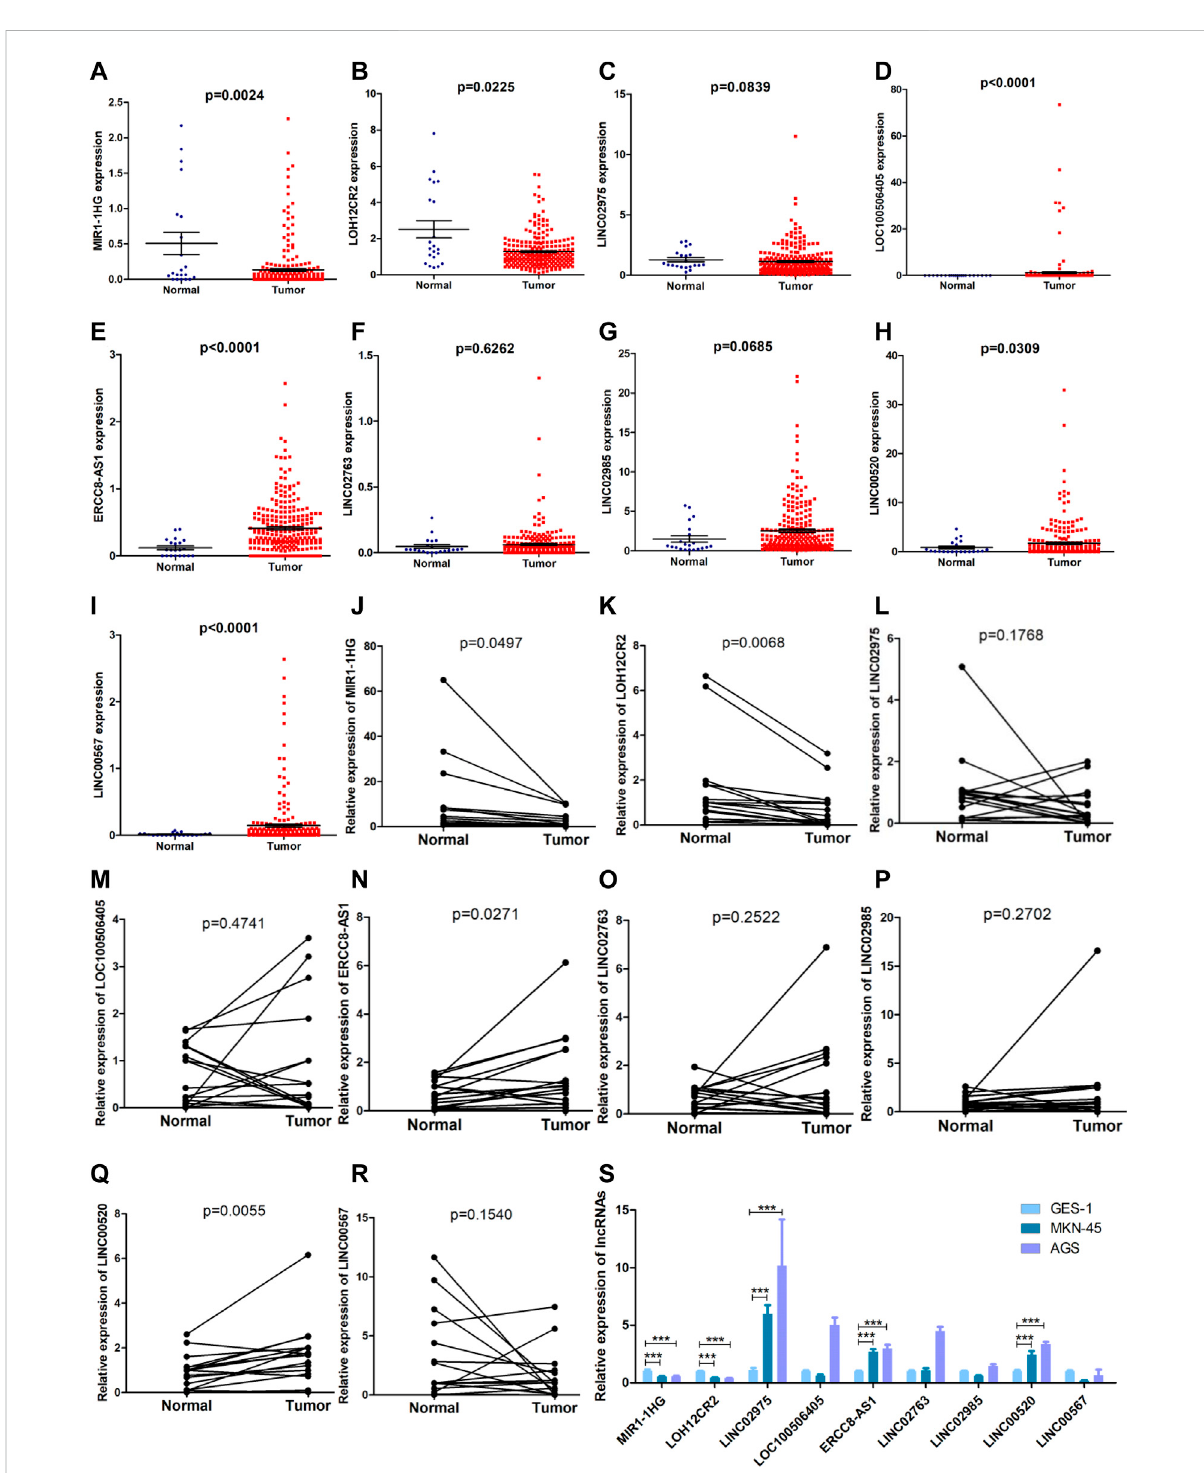
FIGURE 10 Evaluation of the expression of nine lncRNAs in the risk model. (A – I) Comparison of the expression levels of the nine lncRNAs between tumor tissues and normal tissues in TCGA datasets (Mann-Whitney U test). (J – R) The expression levels of the nine lncRNAs in 16 paired GC samples detected using qRT-PCR (paired t test). (S) The expression levels of the nine lncRNAs in two human gastric cancer cell lines (MKN-45 and AGS) and one human gastric epithelial cell (GES-1) (Mann-Whitney U test, ***: p <